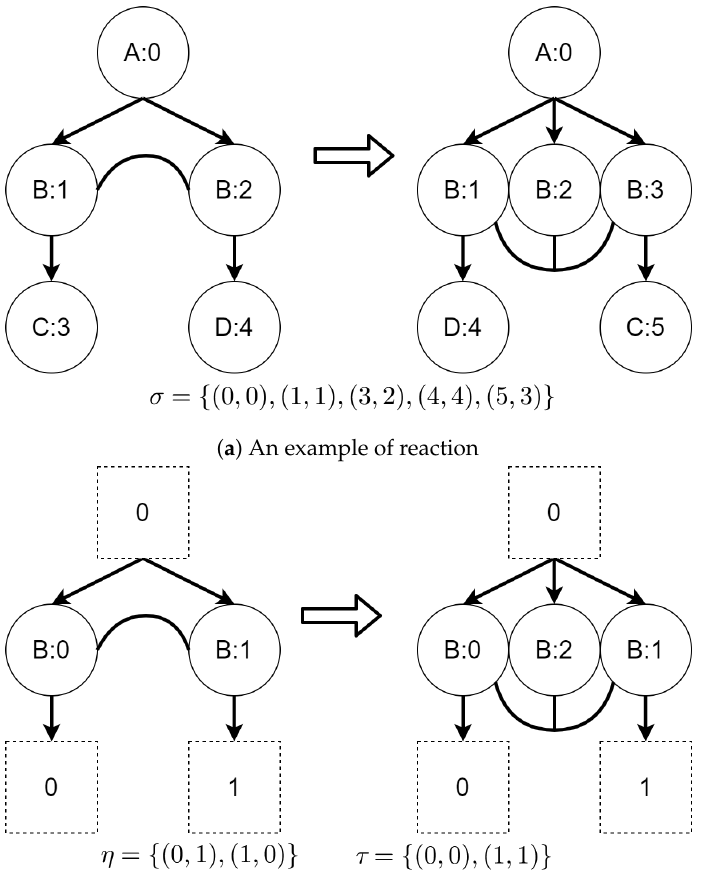
Figure 2. An example of bigraphical reaction with a corresponding reaction rule. The switch of vertices with controls C and D is caused by the η function. The σ mapping denotes which vertex in the output bigraph corresponds to which vertex in the source bigraph. It shows that the vertex with id 2 is “new” (it is not a residue of the source